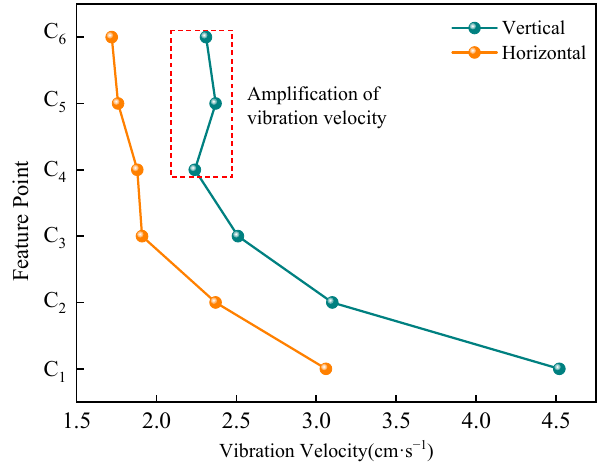
Figure 5. Vibration velocities in the vertical and horizontal directions.